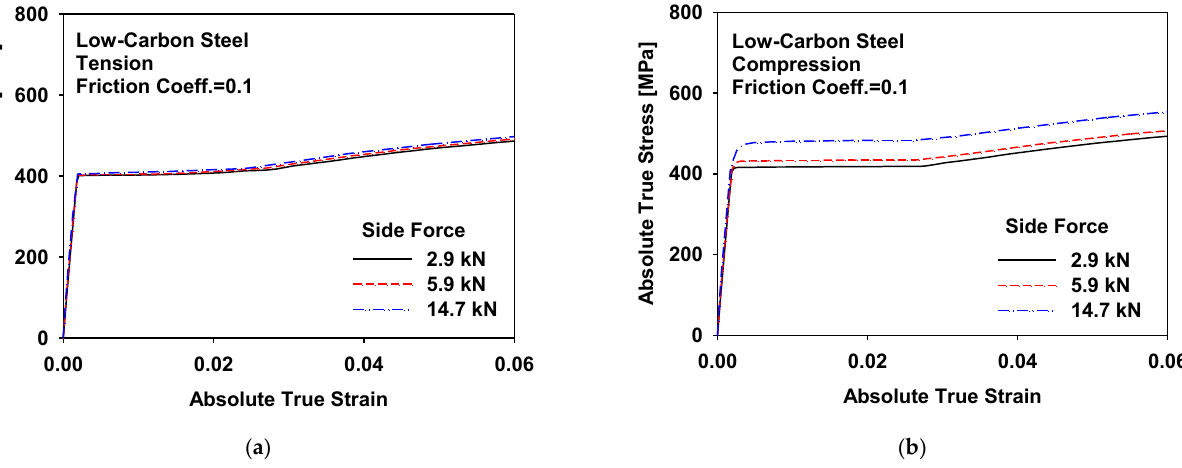
Figure 14. FE calculated stress – strain curves with various side forces for ( a ) tensile and ( b ) compres- sive tests.